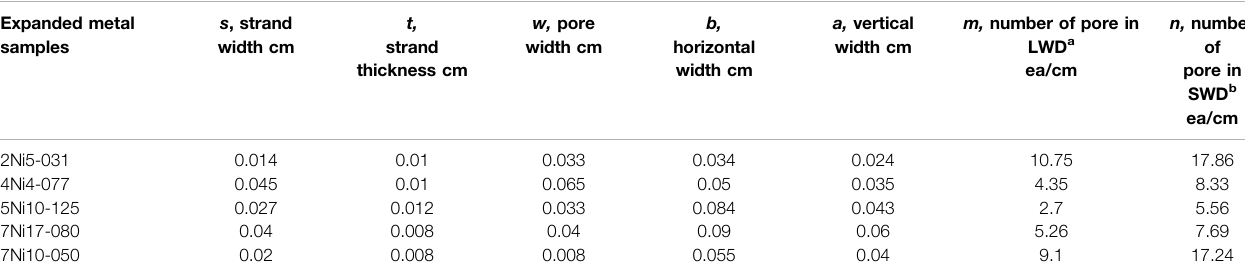
TABLE 2 | Structural parameter of Ni expanded mesh samples. Expanded metal samples